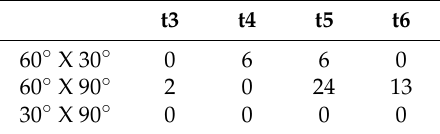
Table 10. Significant difference scores (%) between the three task area sizes (laboratory